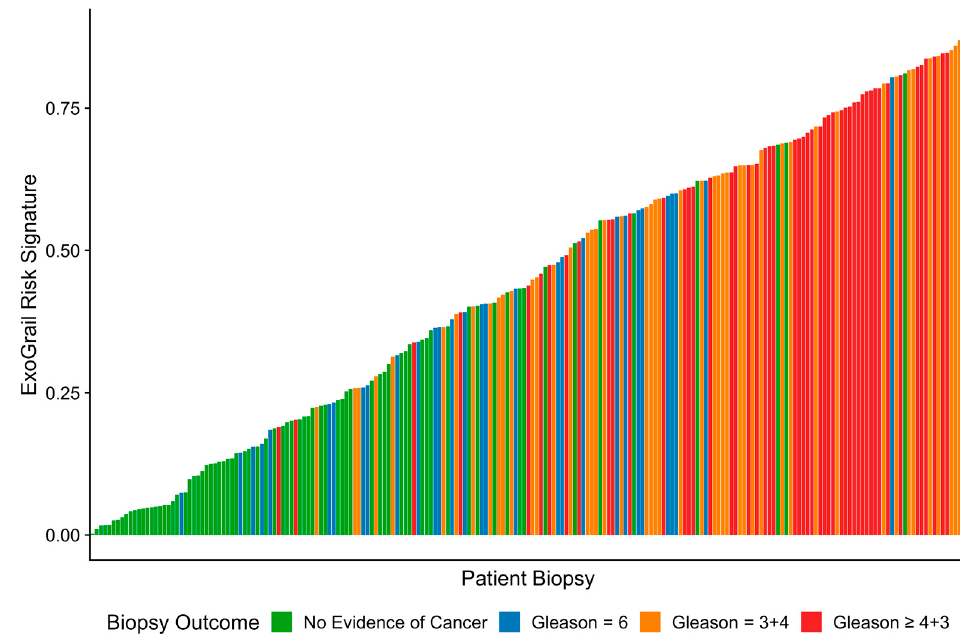
Figure 2. Representation of the ExoGrail risk score for each patient within a waterfall plot, where each coloured bar represents an individual’s biopsy outcome (fill colour) and predicted ExoGrail risk score (bar height). Green—No evidence of cancer, Blue—Gs 6, Orange—Gs 3 + 4, Red—Gs ≥ 4 + 3.